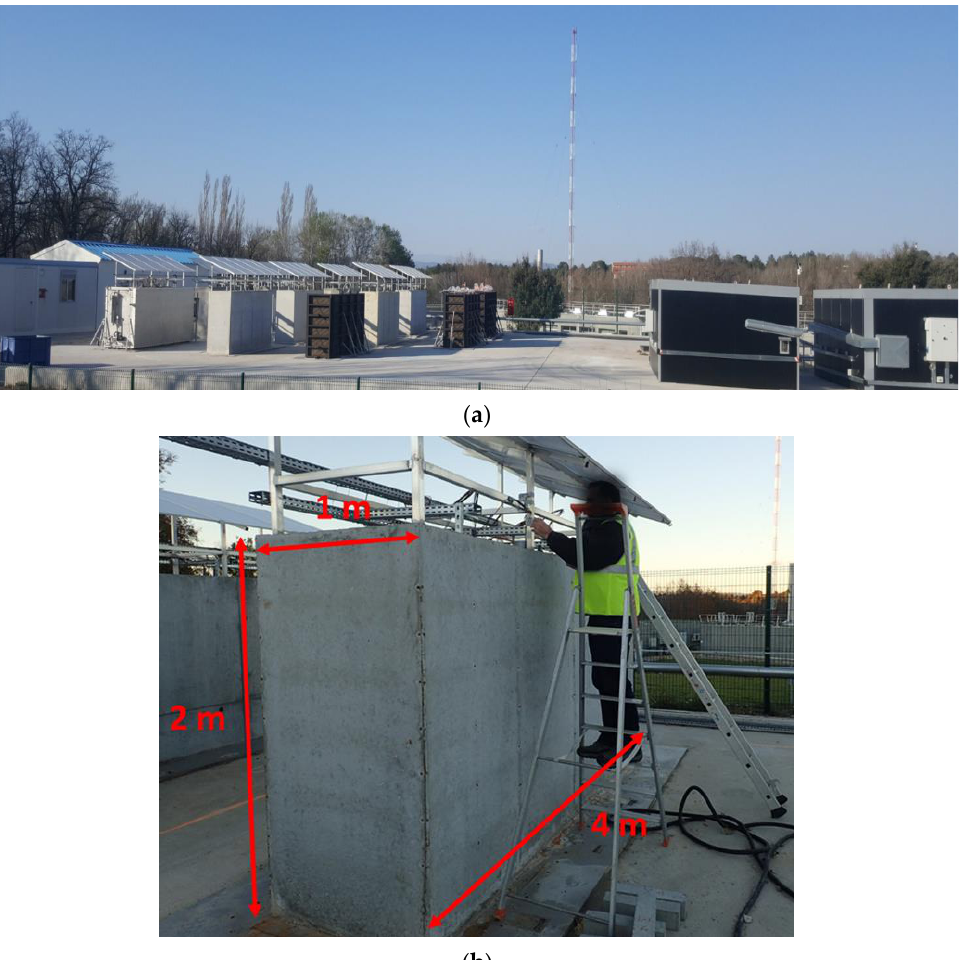
Figure 1. ( a ) Exposure platform for ODOBA blocks, and ( b ) dimensions of the blocks. The studied blocks are either reinforced concrete (RC) blocks or non-reinforced con- crete (NRC) blocks. To continuously monitor temperature and strain at several locations inside the blocks, thermocouples and vibrating wires (VWs) are embedded in the concrete during the fabrication of the blocks. For NRC blocks, thin metallic supports are used to hold the different sensors (see Figure 2a). Differently, for RC blocks, the sensors are attached directly to the steel reinforcement of the blocks (Figure 2b).